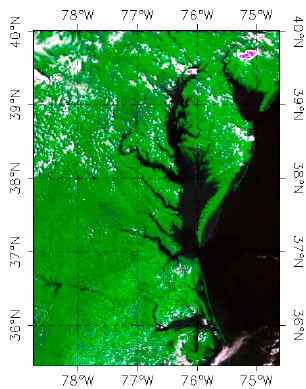
Figure 8. MODIS1B image (bands 3, 2 and 1) in 1 August 2011.